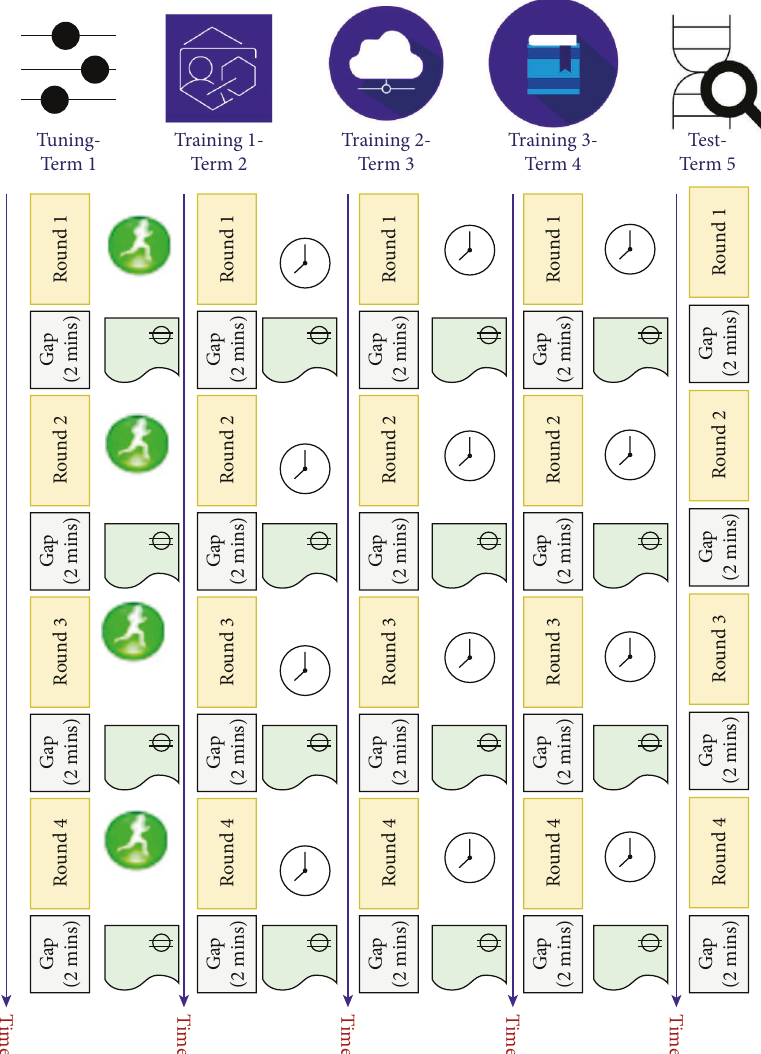
Figure 2: Organization of terms and rounds within the